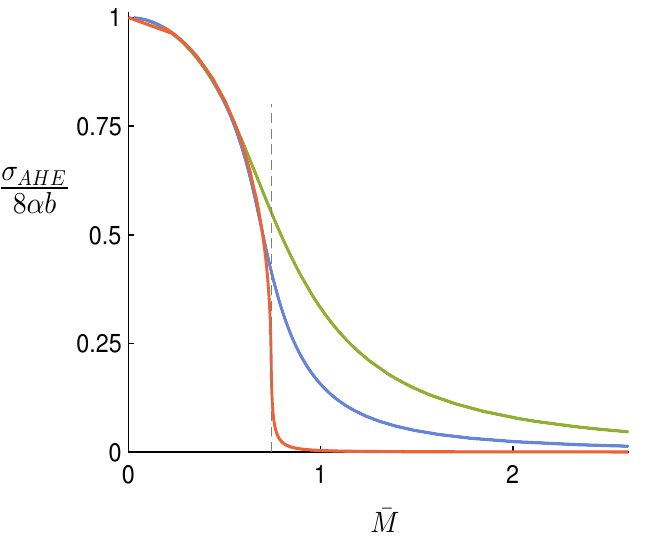
Figure 3. Anomalous Hall conductivity (obtained from (cid:27) xy ) as a function of the dimensionless mass parameter (cid:22) M for temperatures (cid:22) T = 0 : 1 ; 0 : 05 ; 0 : 005 (from green to orange). Note for a very low temperature the conductivity sharply drops to zero at a critical value, (cid:22) M c (cid:24) 0 : 74. This marks the semimetal-insulator topological phase transition.